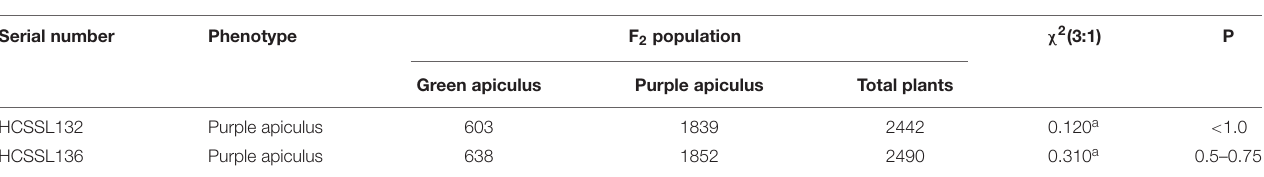
FIGURE 8 | Substitution mapping of Pa-6-2 for purple apiculus on rice chromosome 6. The substituted segments from ZhangPu wild rice were denoted by dark bars; the green areas indicate regions that were heterozygous genotypes for Dongnanihui 810 and ZhangPu Wild Rice; the substituted segments from ZhangPu wild rice were denoted by black bars with the assumption that a segment flanked by one marker of donor type and one marker of recipient type was 50% donor genotype. For the purposes of mapping, however, the full region between one marker of donor type and one marker of recipient type was used as the boundary on each end. The vertical bars through the CSSLs designate the region to which the gene was mapped. TABLE 4 | Plants segregating for purple